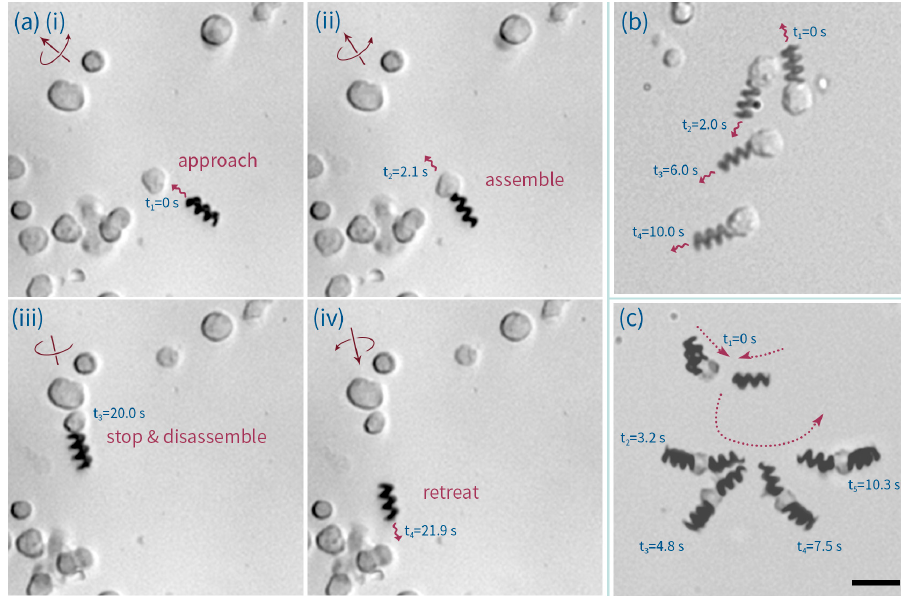
Figure 6. ( a ) The process by which a motorized cell is assembled and disassembled. In (i) and (ii) an ABF approaches the desired cell, contacts it and assembles. The B-cell-ABF assembly then moves forward following the direction of the applied rotating magnetic field (iii and iv). To disassemble, the rotating direction of magnetic field is simply reversed, allowing the ABF to move back and detach from the cell. ( b ) A time-lapse image of a cell being dragged. ( c ) A time-lapse image of the process of forming an ABF-cell-ABF configuration. The scale bar corresponds to 20 µm.